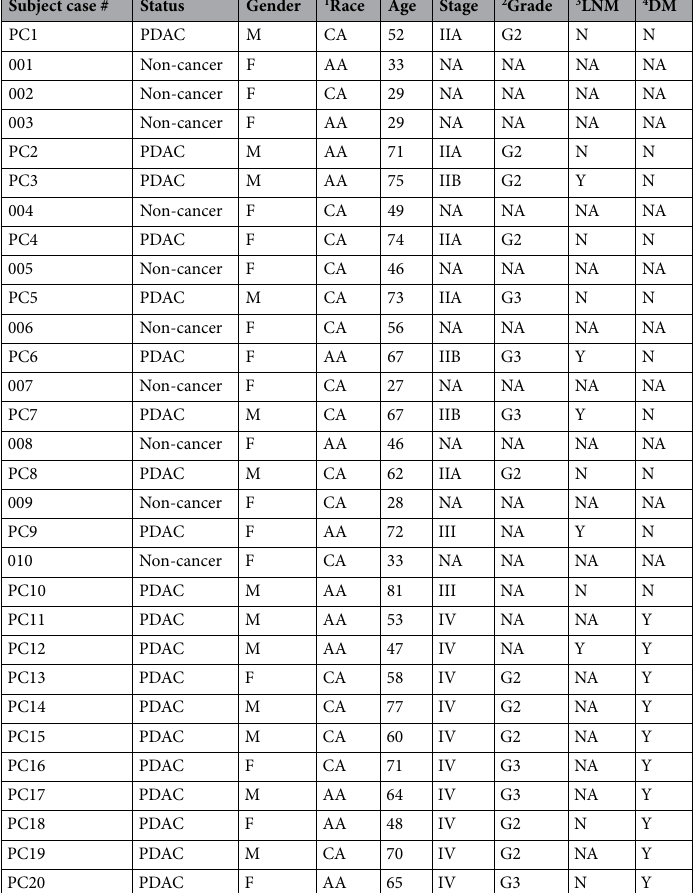
Table 1. Clinical characteristics of PDAC and non-cancer subjects. 1 AA, African American, 1 CA, Caucasian American. 2 G2, moderately differentiated; G3, Poorly differentiated; NA, Not available. 3 LNM, Lymph node metastasis; Y, Yes; N, No; NA, Not available. 4 DM, Distant metastasis; Y, Yes; N,